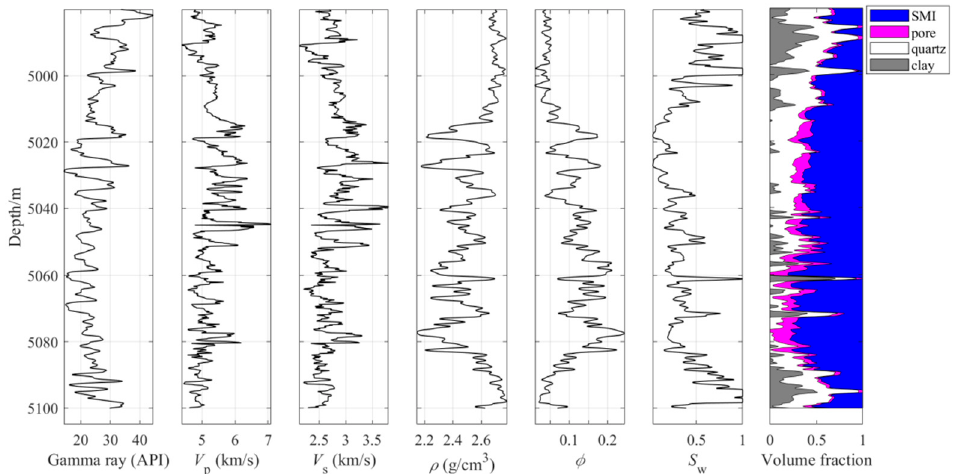
Figure 2. The logging curve and mineral composition information of the reference well section. Table 1. The modulus and density of mineral and pore fluids [43].